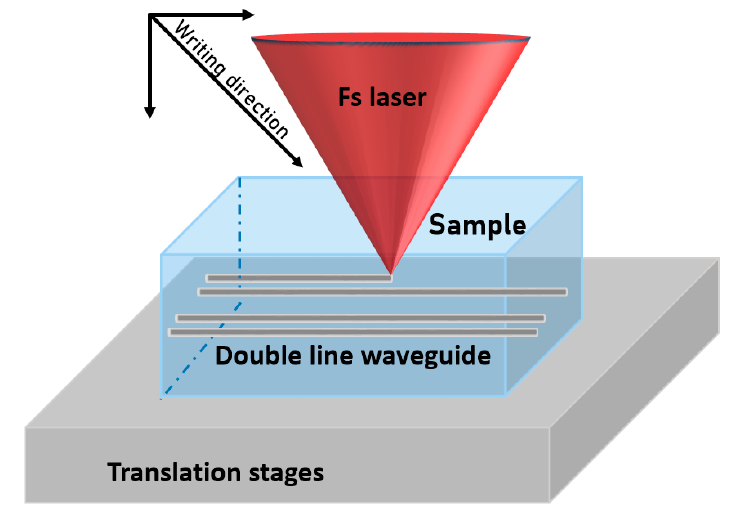
Figure 1. Set-up used for double waveguide processing.